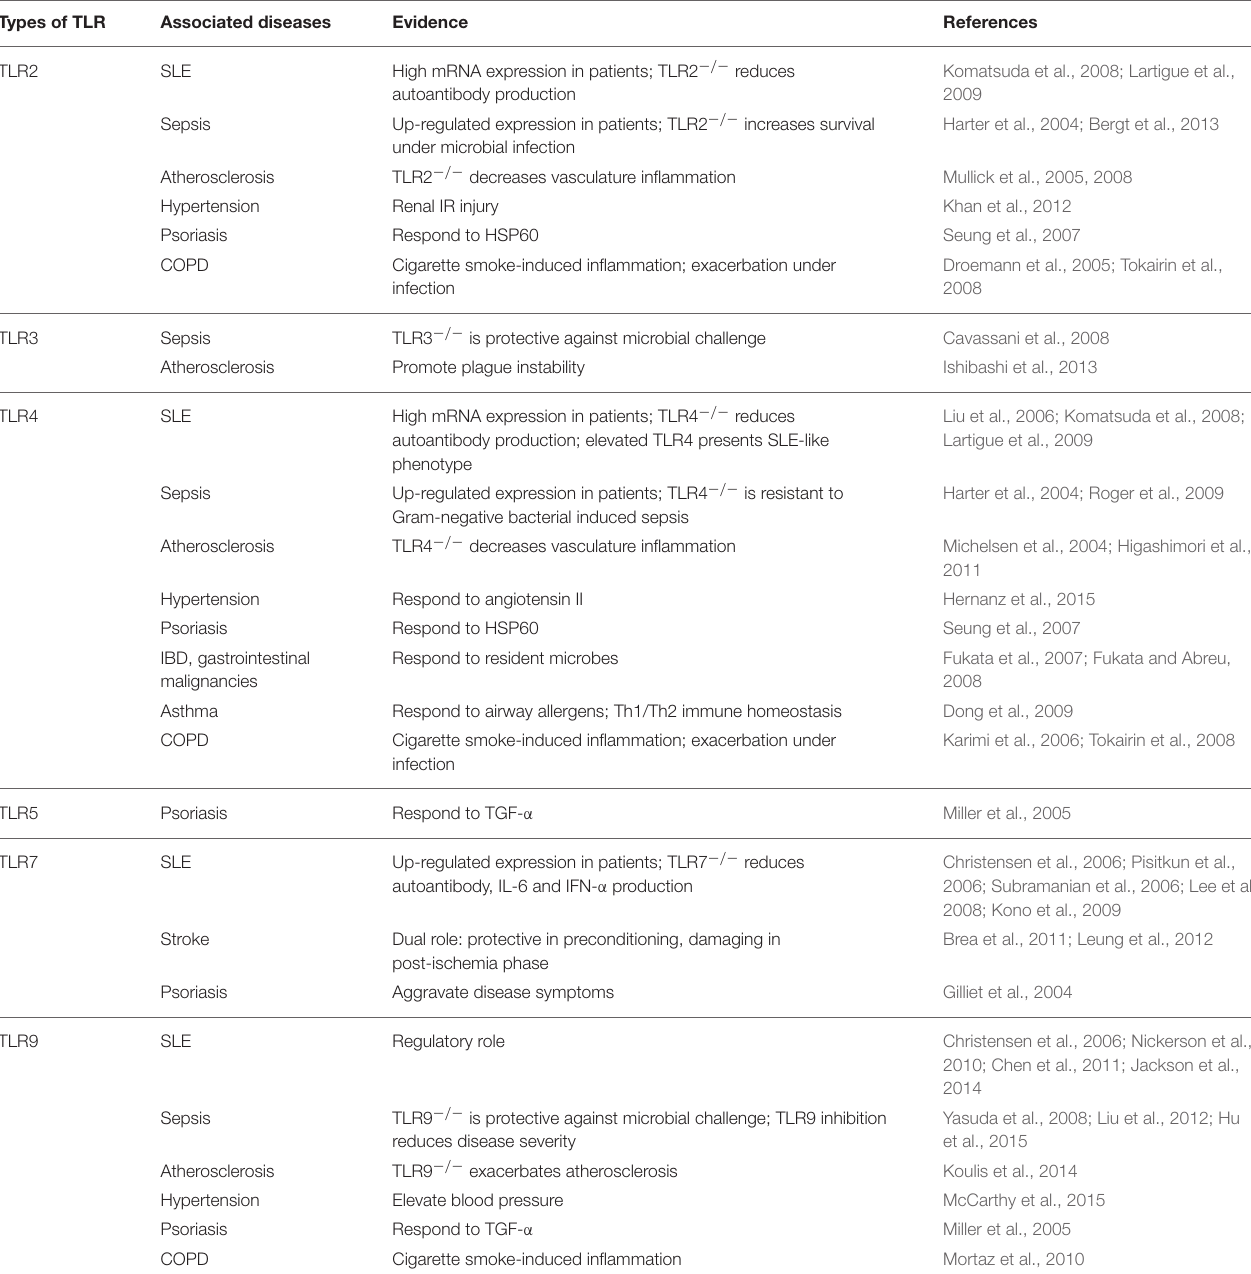
TABLE 1 | The role of TLR activation in the pathogenesis of inflammatory diseases. Types of